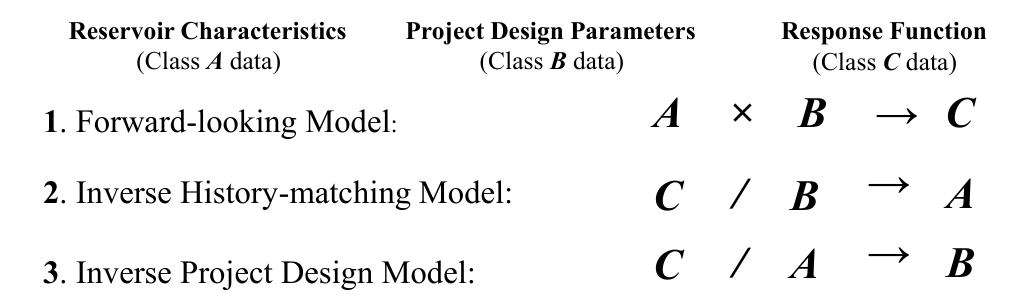
Figure 1. Structures of forward and inverse-looking AI models.